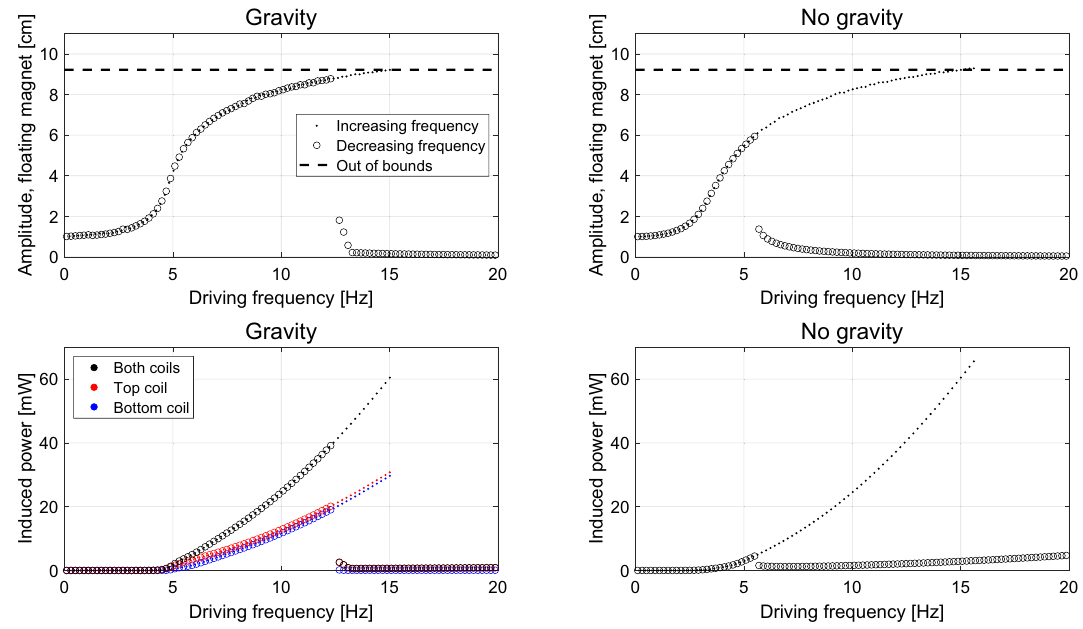
Figure 4. The frequency response of the system in terms of amplitude and induced power, with and without gravity. Note that the amplitude is that as seen from a rest frame. The dots shows the system as it starts at rest, and then slowly ramp up the frequency, giving time at each step for steady state to settle. The circles shows the reverse, where the system starts at 20 Hz, and then slowly ramps down. Only data for systems that reached steady state is